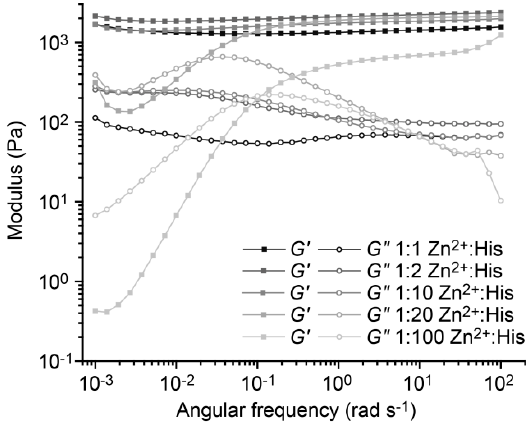
Figure 5. Frequency sweeps of A 4H3 B 4H3 -containing hydrogels with different Zn 2+ :His ratios. The frequency sweeps were performed from 100 to 0.001 rad s − 1 at a constant strain amplitude of 1%, using Zn 2+ :His in ratios of 1:1, 1:2, 1:10, 1:20 and 1:100.